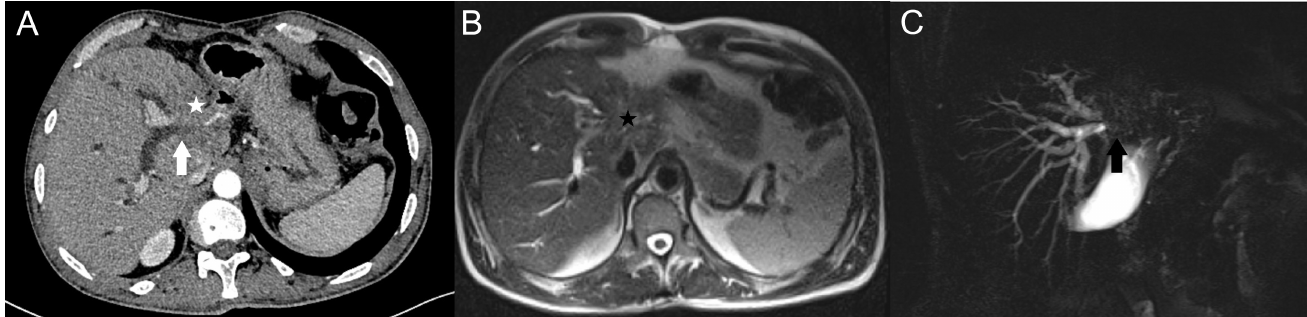
Figure 4. A-C. Axial contrast-enhanced computed tomography (CT) image (A), axial T2-weighted magnetic resonance image (B). and thick slap MRCP (Magnetic resonance chola ngiop ancre atogr aphy) image (C) show an alveolar echinococcosis lesion with Klatskin tumor-like involvement is observed in the left lobe of the liver (white and black stars in A and B). Note that the intrahepatic biliary tract is interrupted at the bifurcation level (white and black arrows in A and C), and capsular retraction is observed in the left lobe of the liver adjacent to the